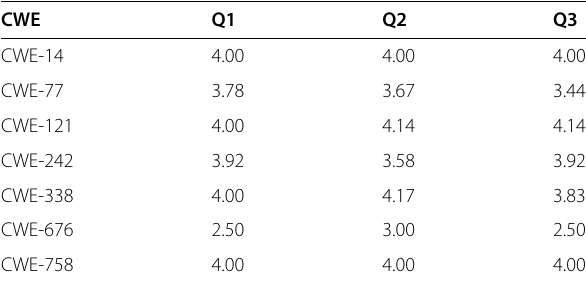
Table 6 Sifu Challenge vs Survey S 1 - Average Agreement CWE Q1 Q2 Q3 CWE-14 4.00 4.00 4.00 CWE-77 3.78 3.67 3.44 CWE-121 4.00 4.14 4.14 CWE-242 3.92 3.58 3.92 CWE-338 4.00 4.17 3.83 CWE-676 2.50 CWE-758 4.00 4.00